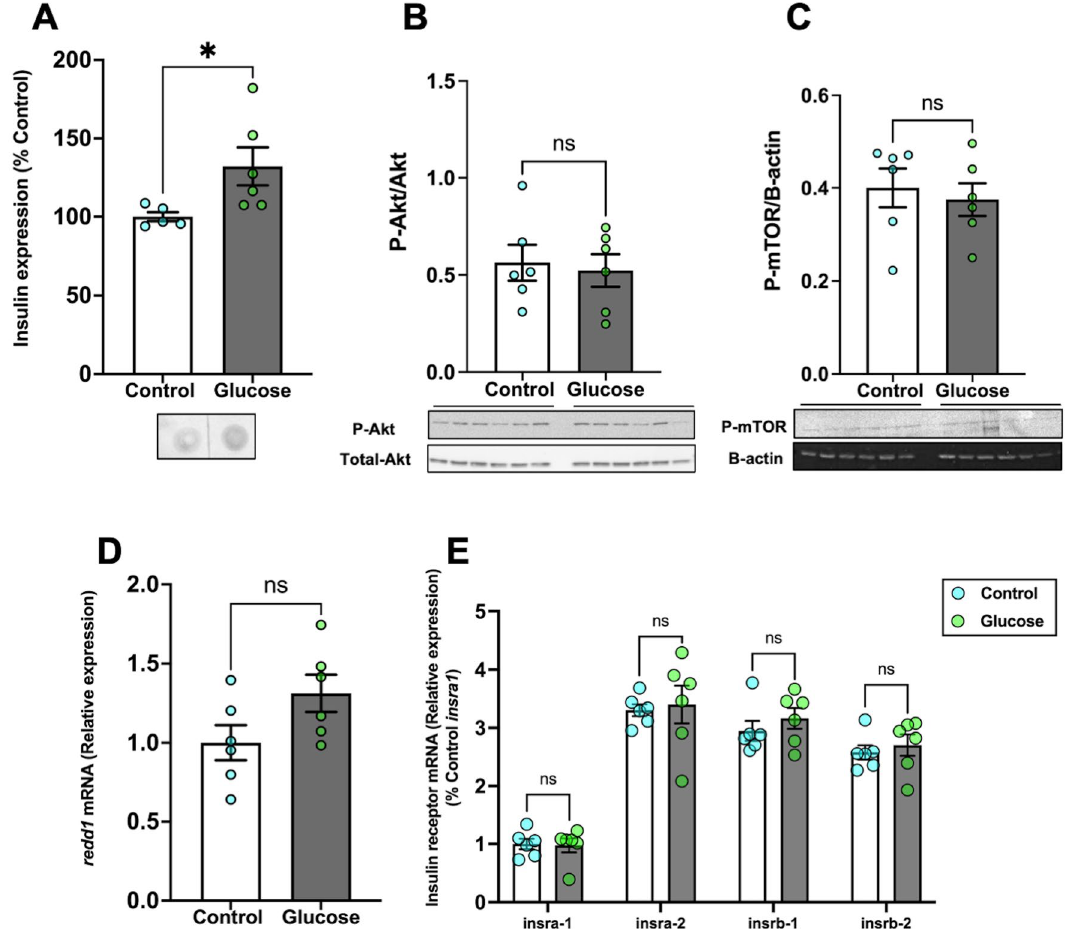
Figure 3. Glucose did not affect Akt and mTOR phosphorylation. ( A ) Whole-body insulin expression significantly increased after glucose exposure compared to the control. ( B ) Glucose exposure did not alter the ratio of phosphorylated to total Akt (M.W.:60 kDa) in the brain when compared to the control. ( C ) The phosphorylation of mTOR (M.W.:289 kDa) also remained unchanged in the glucose-treated fish compared to the control. ( D ) Brain redd1 mRNA levels remained unchanged in the glucose-treated fish compared to the control. ( E ) The transcript levels of the insulin receptor genes in the brain did not change after glucose treatment. Values are means ± SEM. (Whole-body insulin n = 5–6; Protein expression n = 6; Transcript abundance n = 6). ns—not significant; *( P <